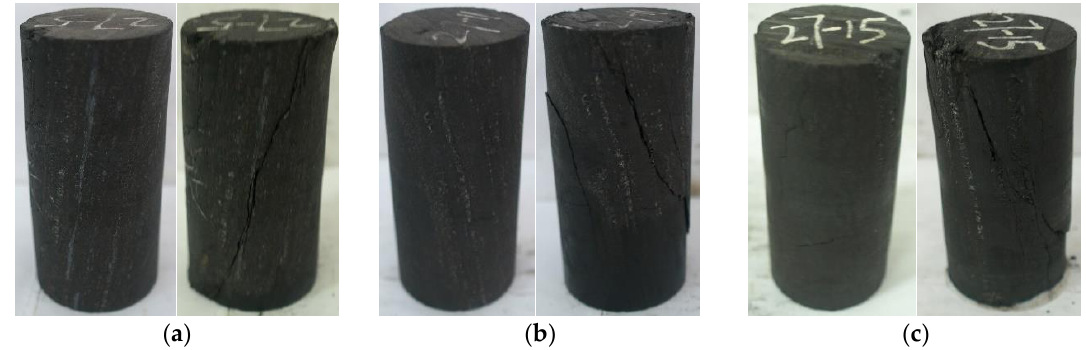
Figure 4. Comparison of coal samples before and after testing under different gas pressures: ( a ) 27-5 (0.5 MPa); ( b ) 27-11 (1 MPa); ( c ) 27-15 (2 MPa).